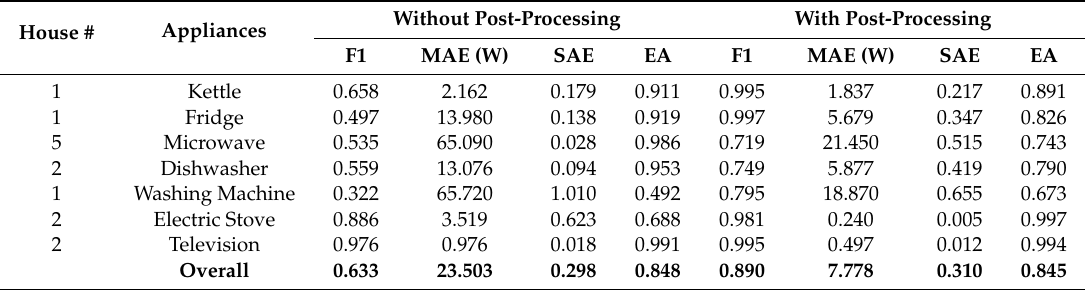
Figure 7. Seen Scenario—Disaggregation results of some target appliances from the UKDALE dataset with and without post-processing. Table 2. Performance evaluation of the proposed algorithm in a seen scenario based on the UKDALE datasets.